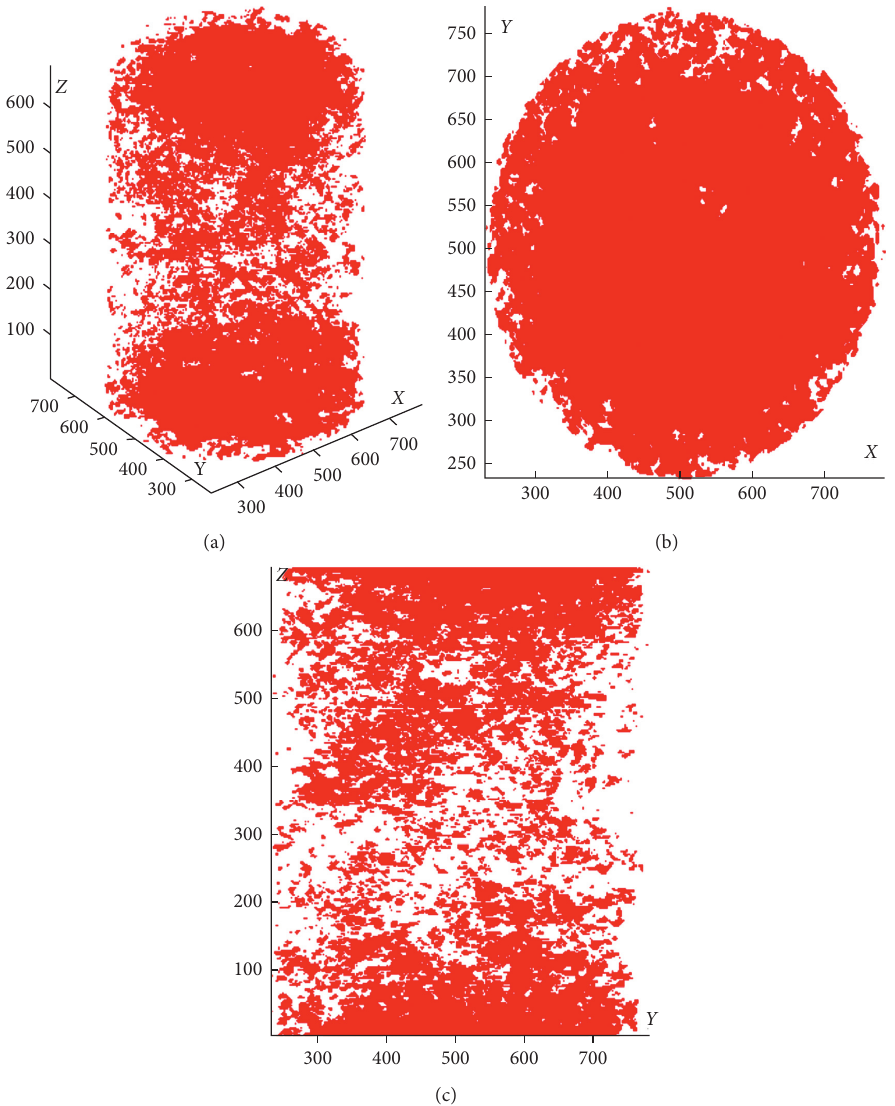
Figure 13: Air void distribution of SUP13 specimen. (a) Three dimensions. (b) Projection in transverse section. (c) Projection in vertical